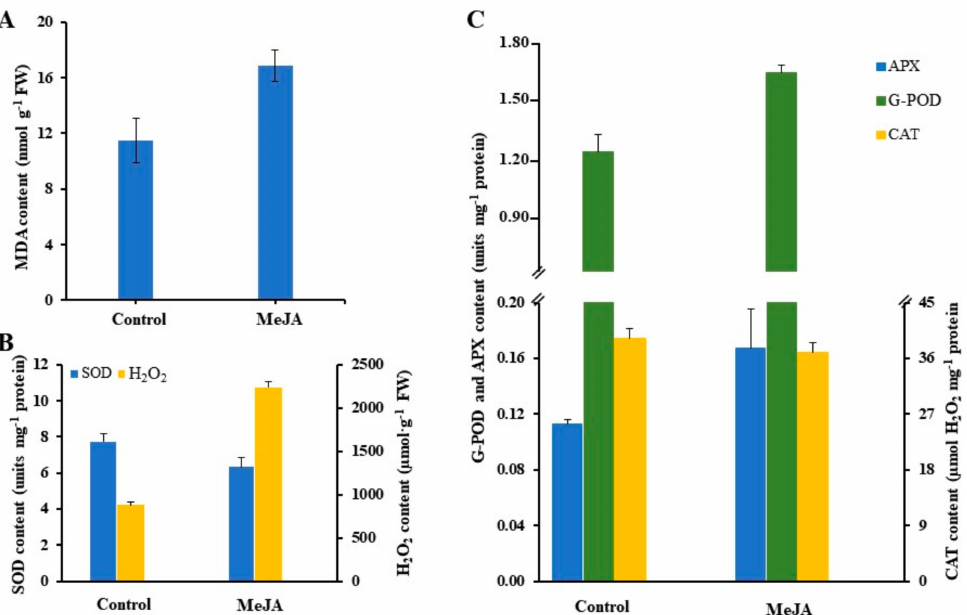
Figure 4. E ff ect of MJ on malondialdehyde (MDA) content ( A ), and antioxidant enzyme activity ( B , C ) in adventitious root cultures of Cnidium o ffi cinale . SOD superoxide dismutase, CAT catalase, G-POD guaiacol peroxidase, APX ascorbate peroxidase. Values represent mean ± SE ( n =